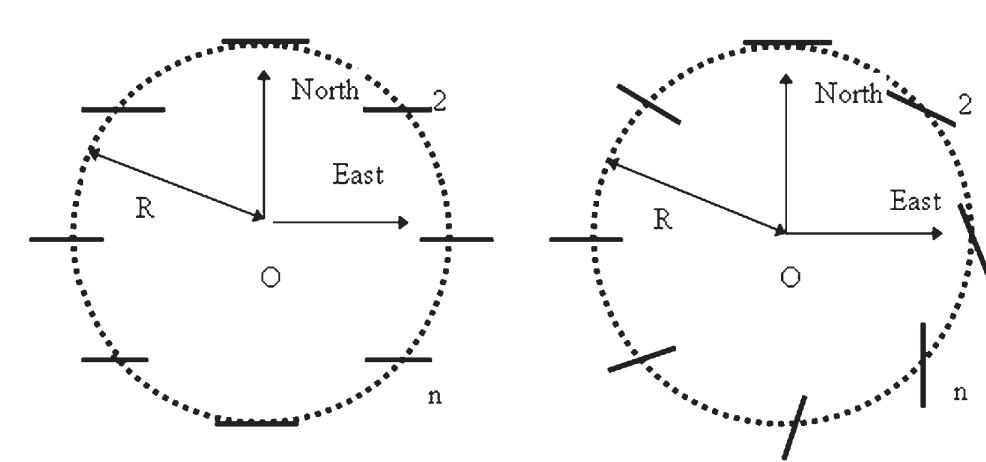
Fig. 6.a,b. Homogeneous circular array (left frame) and heterogeneous circular array (right